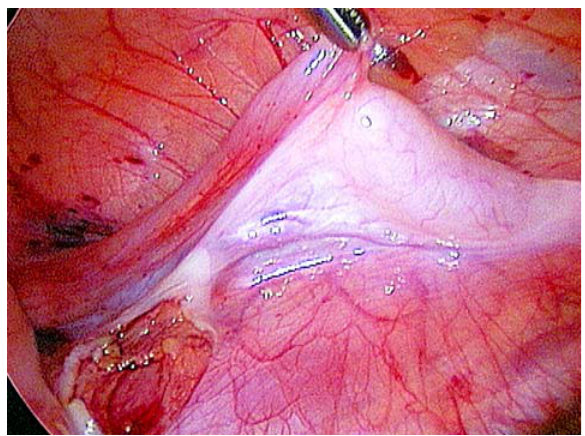
Figure 3 – Laparoscopic view of the left testicle. When we were mobilizing the testicle, we noticed the absence of the epididymis body and tail.